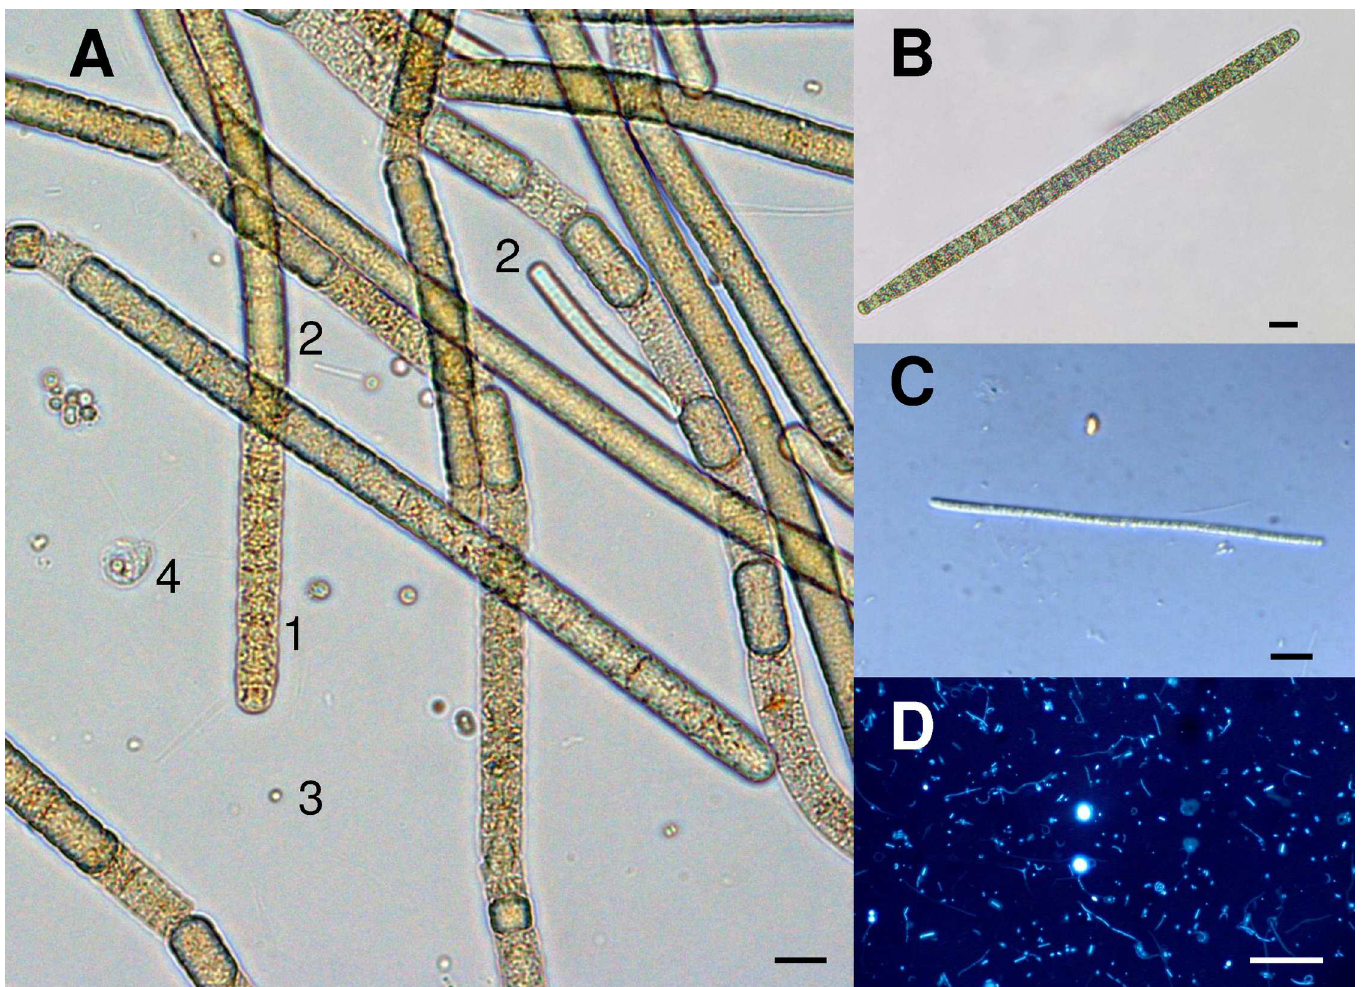
Fig 5. Microscopical photographies of plankton samples of Dziani Dzaha (surfacesample, 2011 survey). (A) Total phytoplankton community after Lugol stainingwith large Arthrospira sp. trichomes (1), thin filaments belongingto the Leptolyngbyaceaefamily (2), unidentifiedcoccoidalcells (3), and large eukaryoticcolored flagellate (4). (B) Generalview of Arthrospira sp. (C) Generalview of thin filaments of cyanobacteria belongingto the Leptolyngbyaceae family. (D) Epifluorescence microscopy picture after SybrGold staining of nucleicacids, highlightingbacterioplankton morphologicaldiversity. Scale